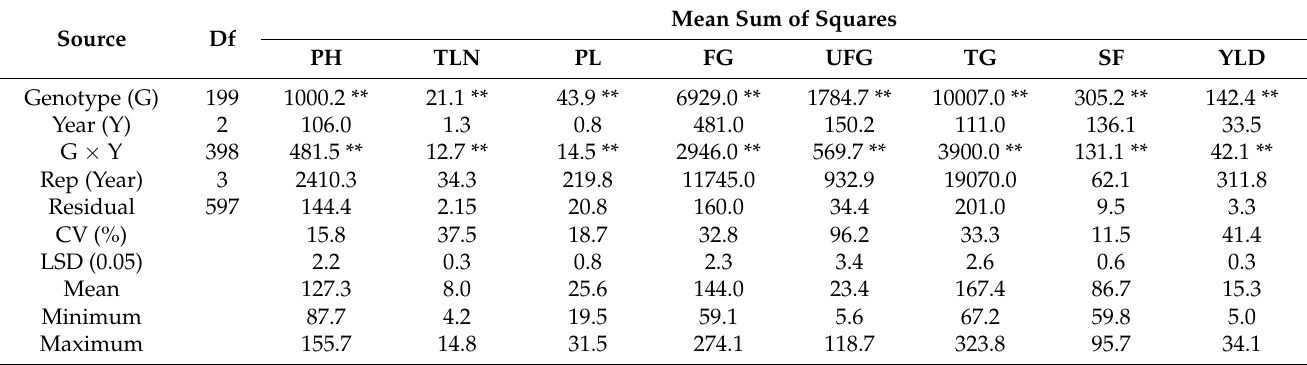
Table 1. Analysis of variance for the morphological traits among the tropical japonica lines grown during three consecutive seasons (environments) at New